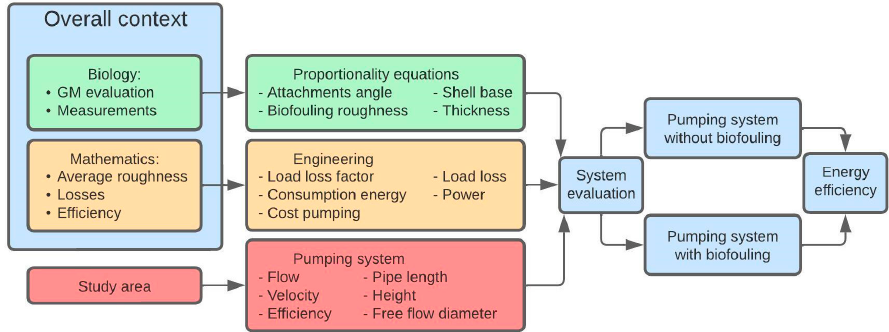
Figure 1. Schematic representation of the activities developed in this work.